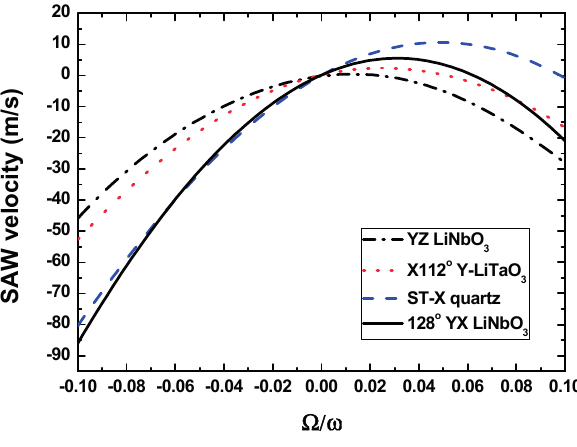
Figure 3. Gyroscopic effect in various piezoelectric substrates without metallic